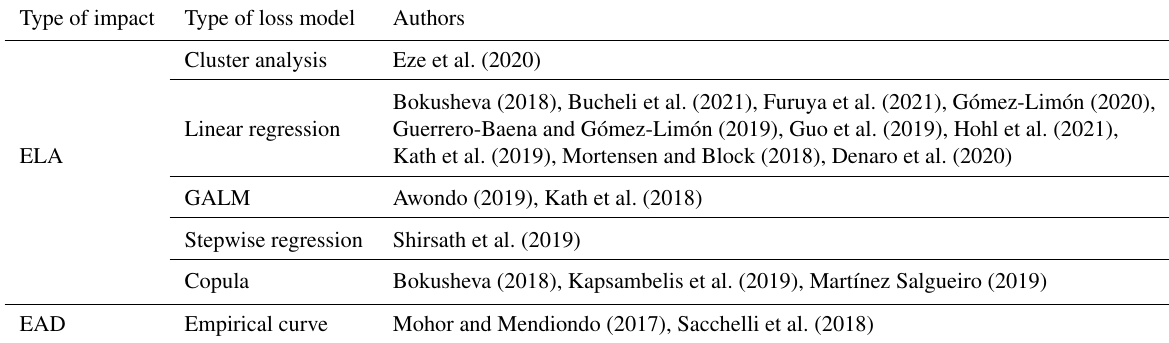
Table 3. Summary of expected loss amount (ELA) and expected annual damage (EAD)